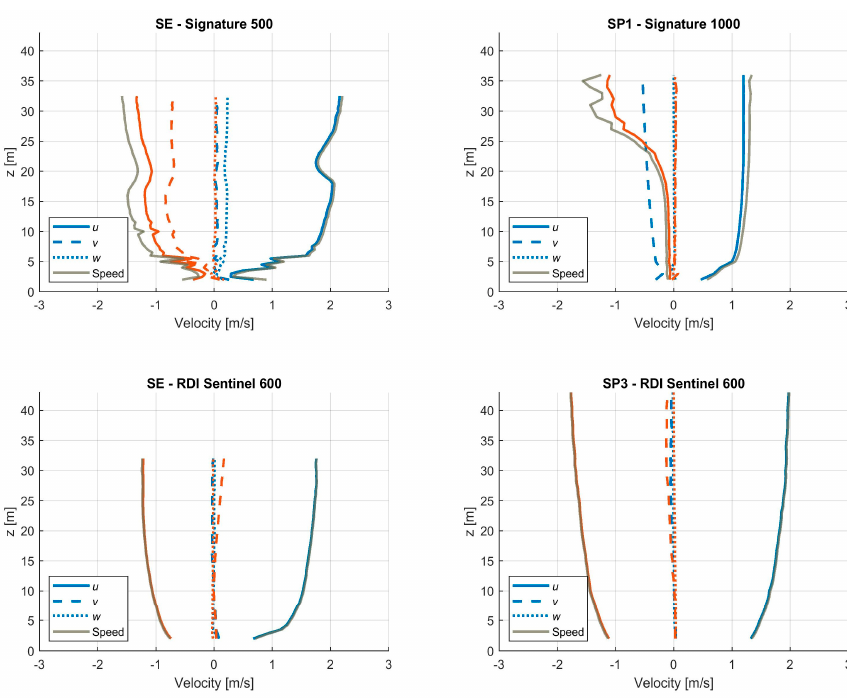
Figure 4. Average peak flood and ebb flow profiles for each sensor for three tidal phases, where blue indicates flood tide and red indicates the ebb tide. The values for the u and speed component of the ebb tide have been inverted to illustrate different flow direction.